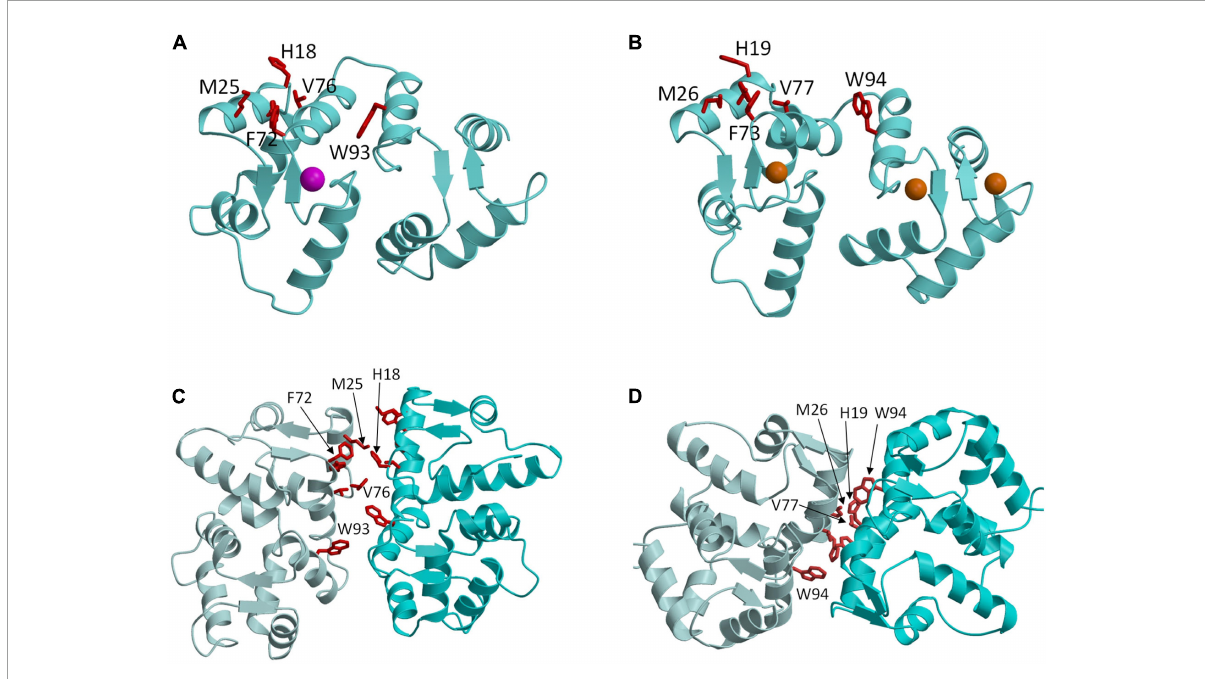
FIGURE3 Molecular structures of GCAP1 and GCAP5. Main chain structures of Ca 2 + -free/Mg 2 + -bound GCAP5 (PDB ID: 7M2M) (A) and Ca 2 + -bound GCAP1 (PDB ID: 2R2I) (B) . Bound Ca 2 + and Mg 2 + are orange and magenta. Dimeric structures of GCAP5 (C) and GCAP1 (D) determined by double electron electron resonance (DEER). Side chain atoms of exposed “hot spot” residues are shown as red